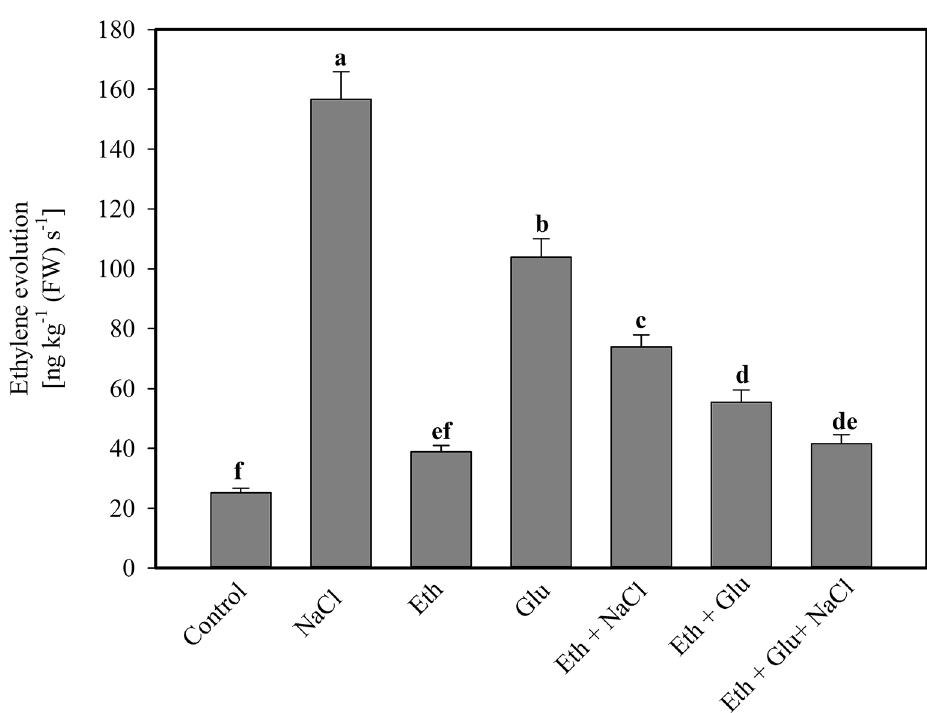
Figure 3. Ethylene evolution in wheat leaves treated with 200 µL L −1 ethephon and / or 6% Glu in the presence or absence of 100 mM NaCl at 30 d after sowing. Data are presented as treatment mean ± SE (n = 4). Data followed by the same letter are not significantly different by LSD test at p < 0.05. Eth, ethephon; Glu,